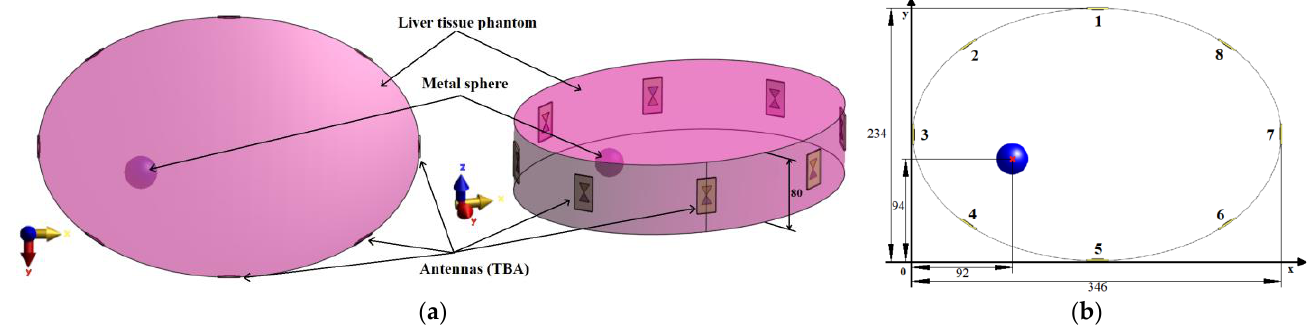
Figure 2. Elliptical cylindrical model: ( a ) Description of individual parts of the model; ( b ) Dimensions of the model and position of the imaged object and antenna numbers. All dimensions are expressed in mm.